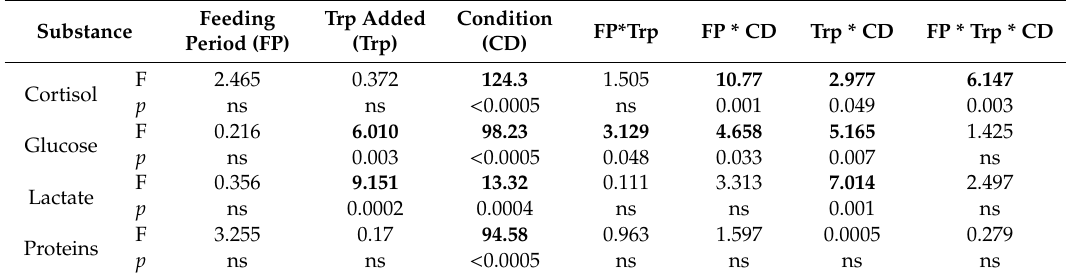
Table 2. Three-way ANOVA parameters ( α = 0.05) for plasma cortisol, glucose, lactate, and proteins. Factors are feeding time (2 / 8 days), Trp added (control / 1% / 2%) and condition (pre- / post-stress); ns = no significant. F is in bold when e ff ects are